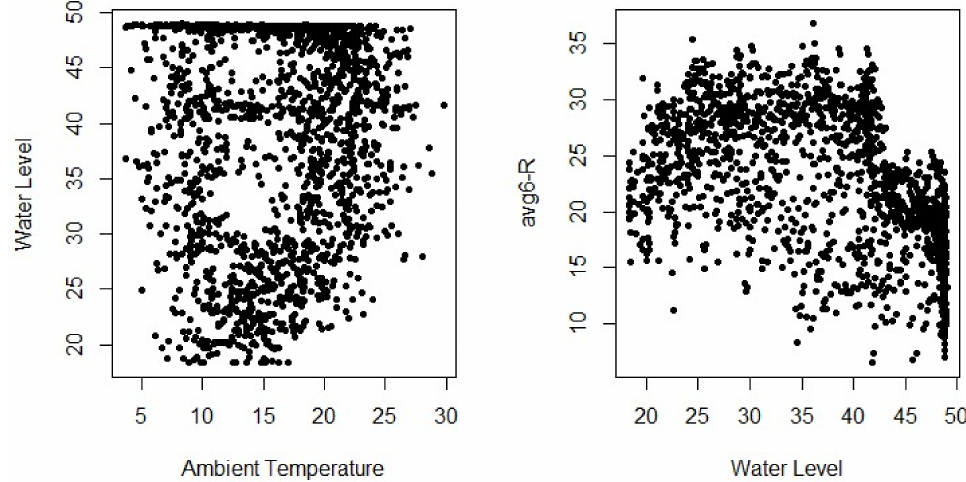
Figure 21. Ambient temperature ( ◦ C) against water level (m) and water level (m) against avg6-R ( ◦ C).